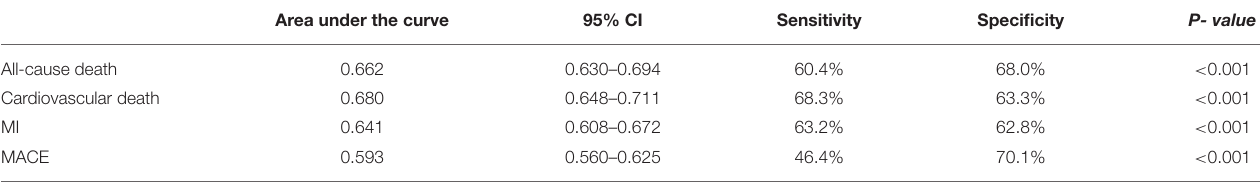
TABLE 4 | Receiver operating characteristic curve evaluation of Log (NT-proBNP) for endpoints